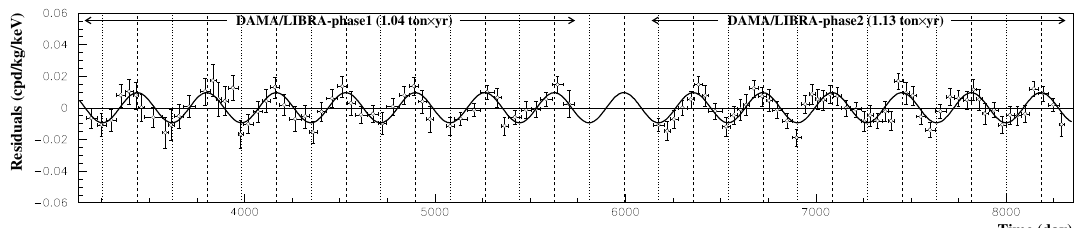
Figure 1. Residual rate for single-hit scintillations measured by DAMA/LIBRA–phase1 and DAMA/LIBRA–phase2 in the (2–6) keV energy interval. The superimposed curve is the cosinusoidal functional forms A cos ω ( t − t 0 ) with a period T = 2 π and modulation amplitude, A , equal to the central value obtained by best fit on the data points of DAMA/LIBRA–phase1 and